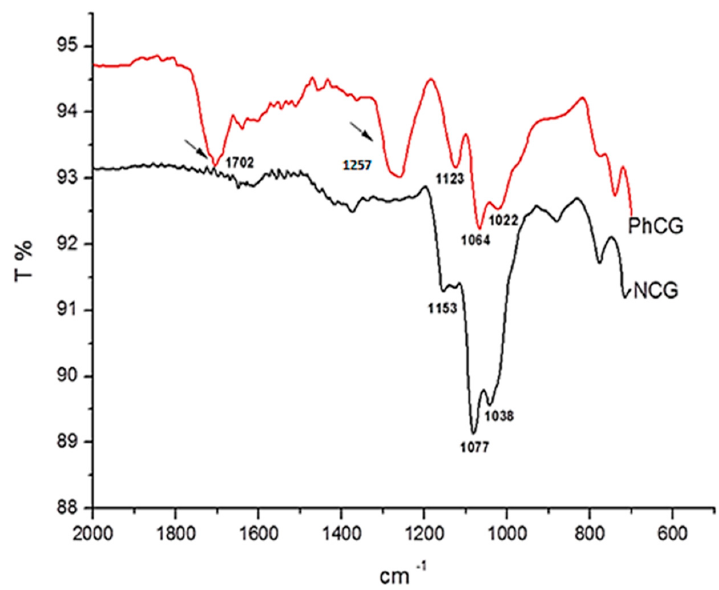
Figure 2. Attenuated total reflection (ATR)—Fourier transform infrared (FTIR) spectra of natural cashew gum (NCG) and phthalated-cashew gum (PhCG). Arrows indicated the new bands due to pthalation (see text).